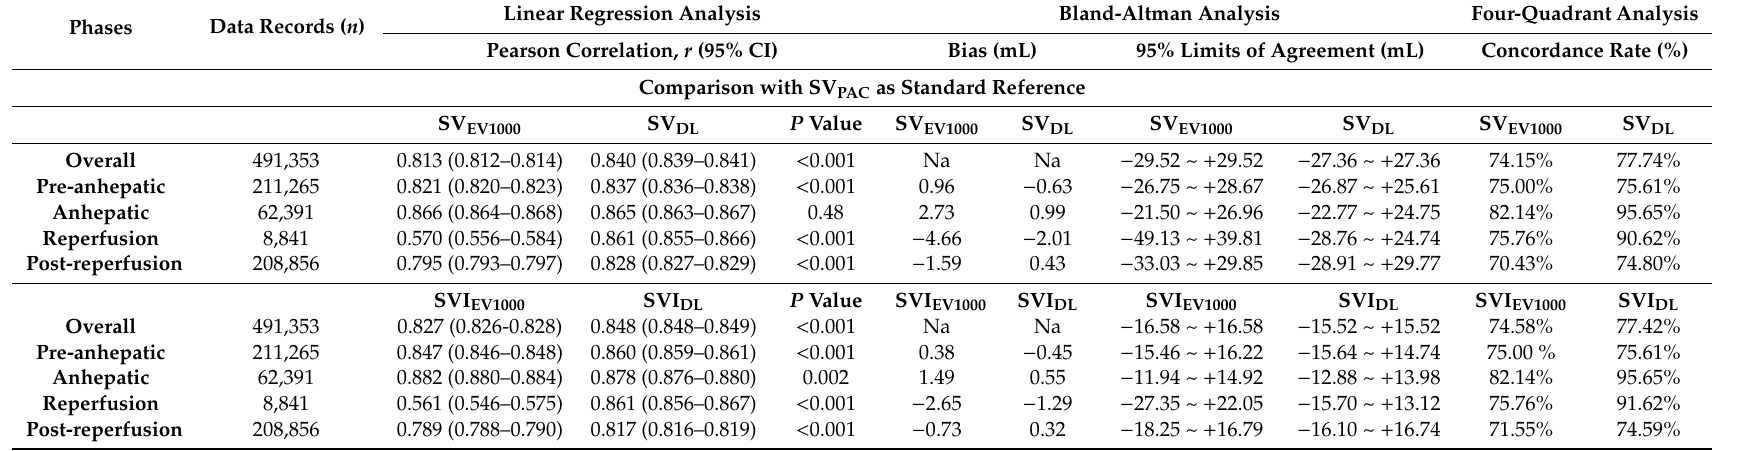
Table 3. Comparative analyses of stroke volume